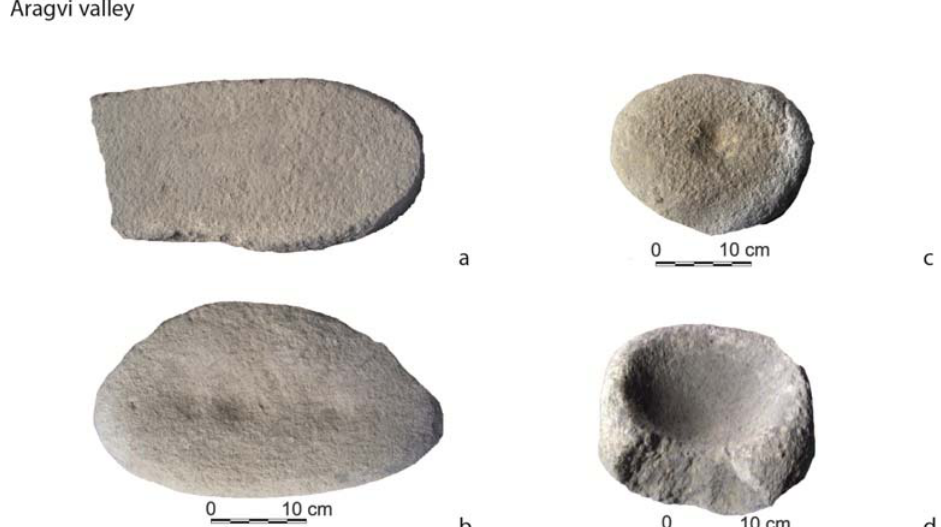
Figure 7. Chalcolithic macrolithic implements. Argavi valley: a. grinding tool on cobble (Abasnorevi, Aragvi valley); b. grinding tool used as crushing slab (Chinti); c. Crusher (Chinti); d. mortar (Chinti) (photographs by C.